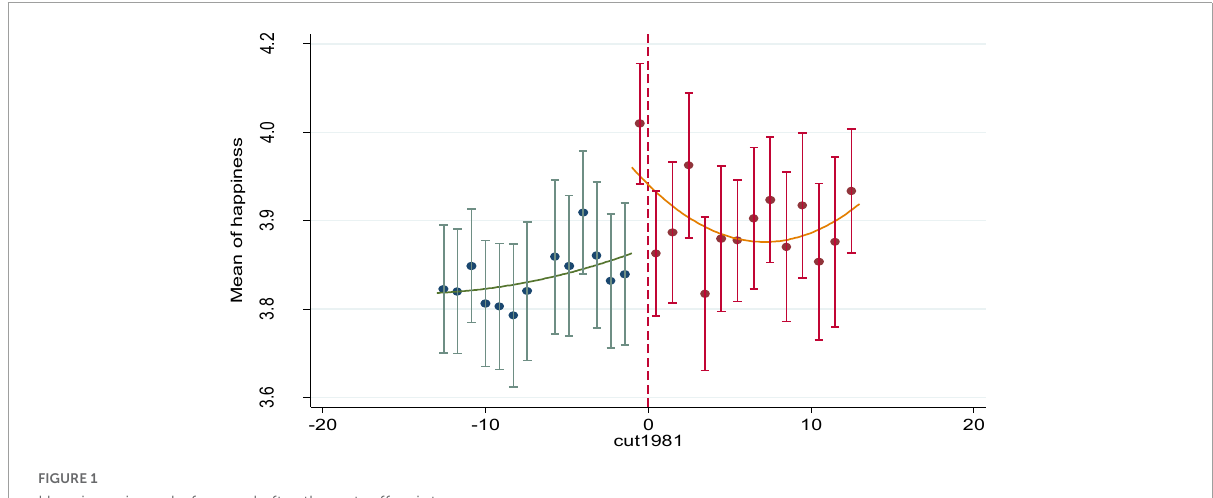
FIGURE1 Happiness jump before and after the cut-off